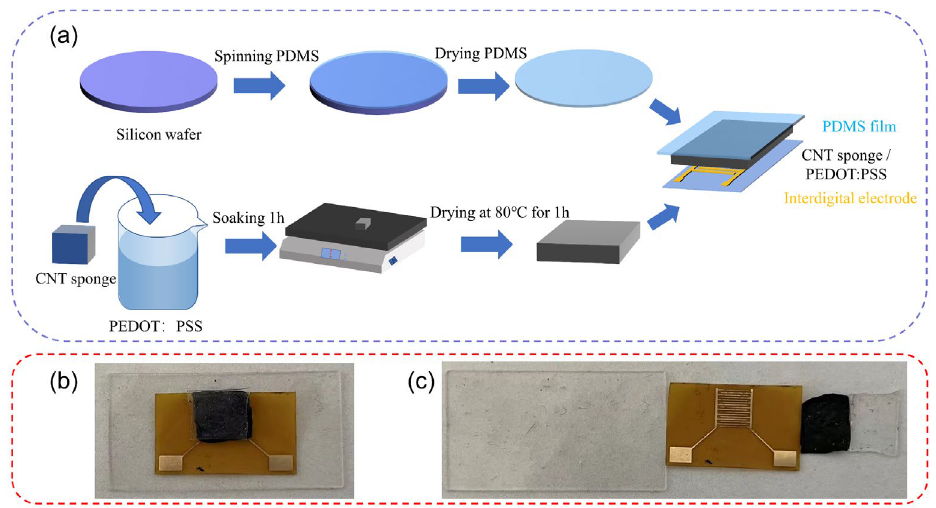
Figure 1. ( a ) Fabrication process of the pressure–temperature dual-parameter sensor. ( b ) Real image of the sensor. ( c ) Real image of each part of the sensor.